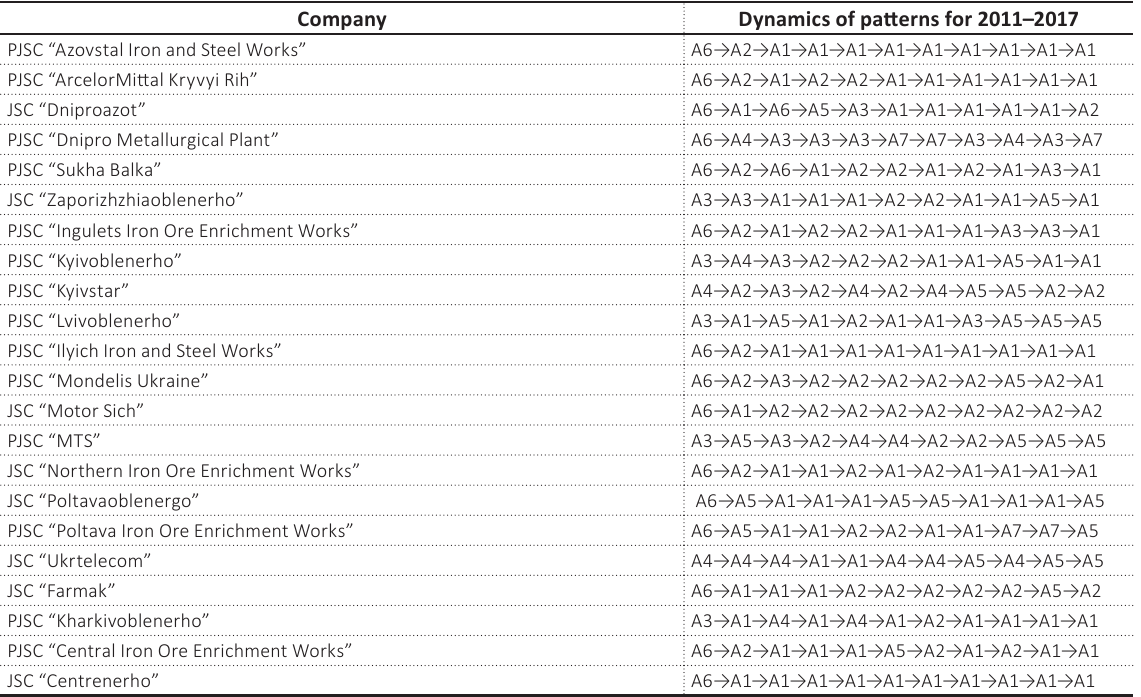
Table 5. Dynamics of the analyzed companies’ patterns for 2011–2017